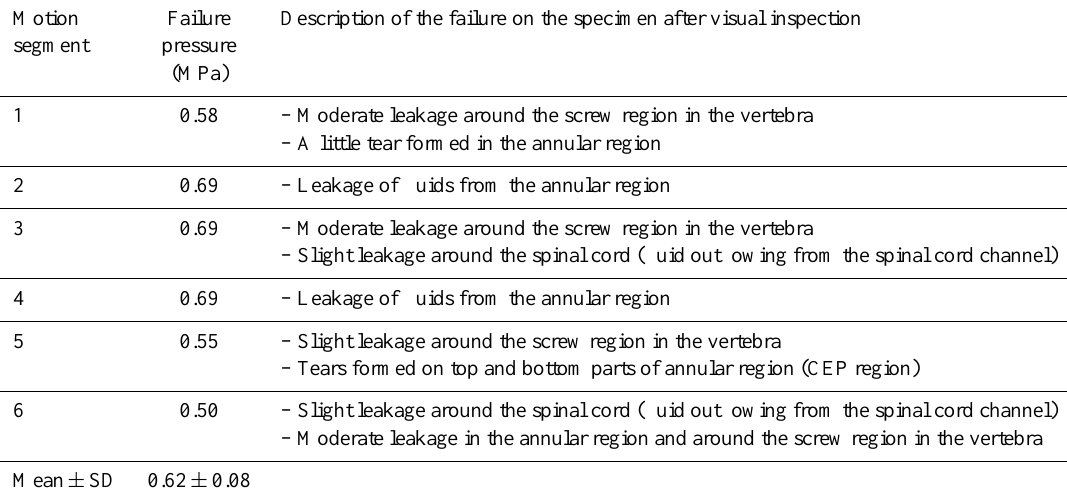
Table 1. Failure pressure (maximum in the curve IDP vs. time) for the 6 motion segments that presents external indicators of rupture, such as sudden pressure drop, leakage in the vertebra region or in spinal cord (fluid outflowing from the spinal cord channel) or tears formed on the annular region or also on the top and bottom parts of annular region (Cartilaginous Endplate